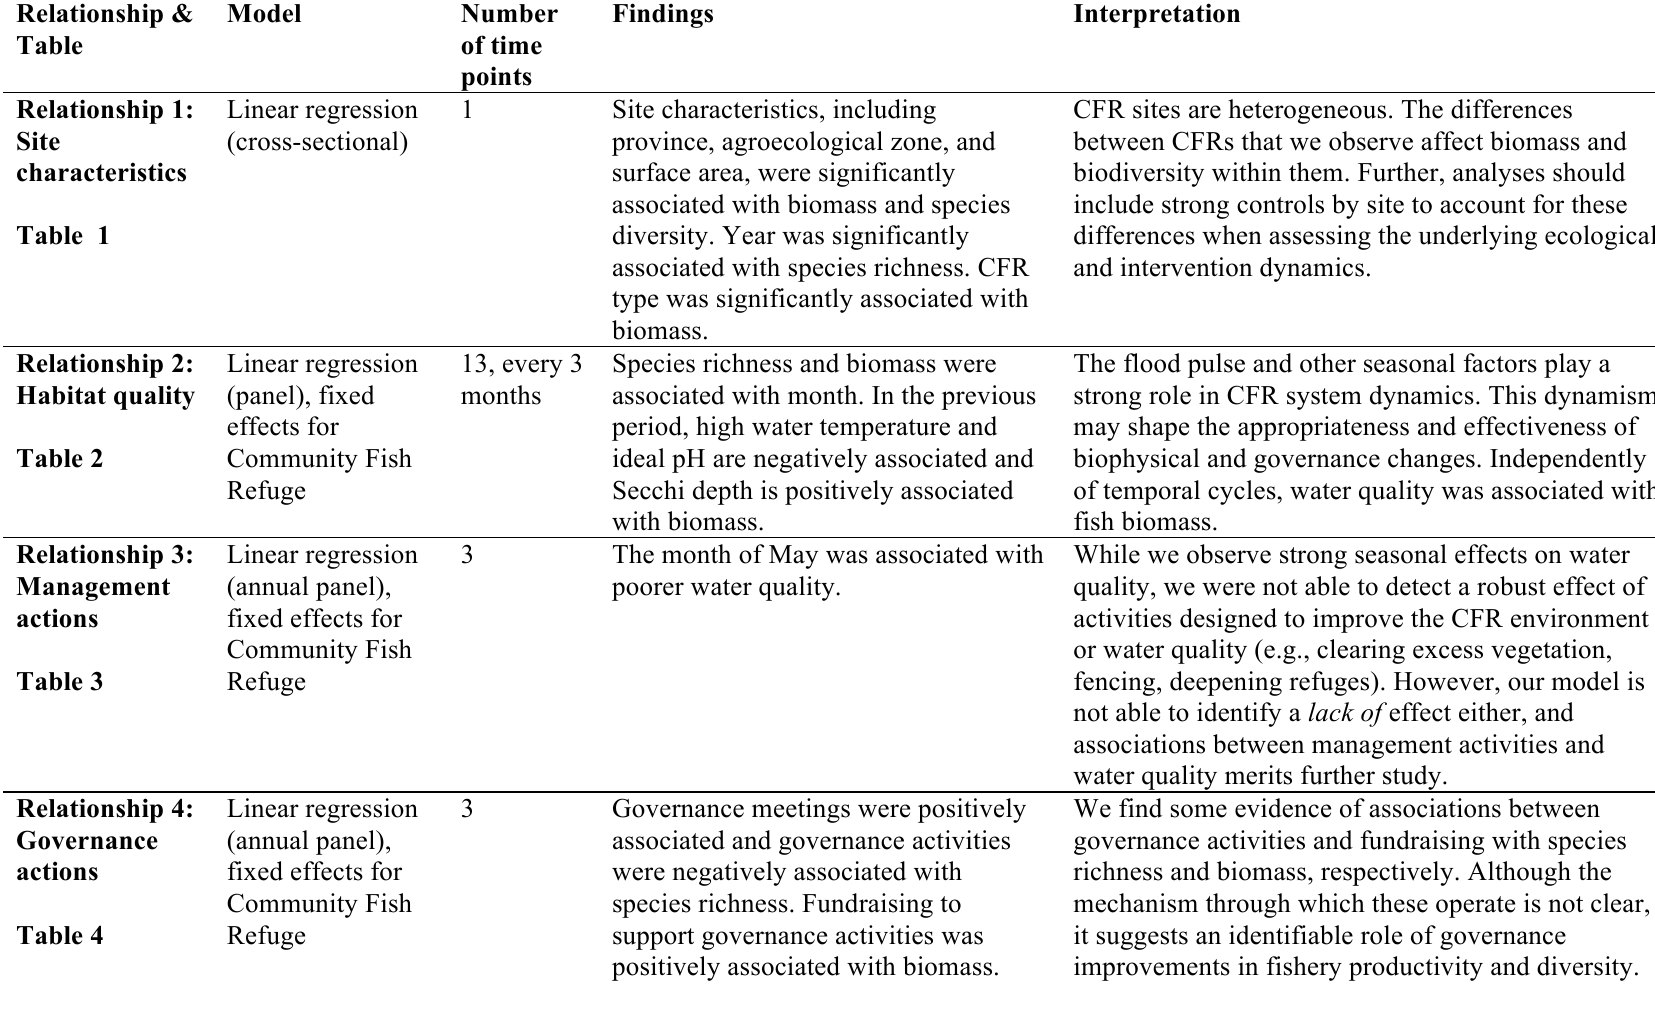
Linear regression